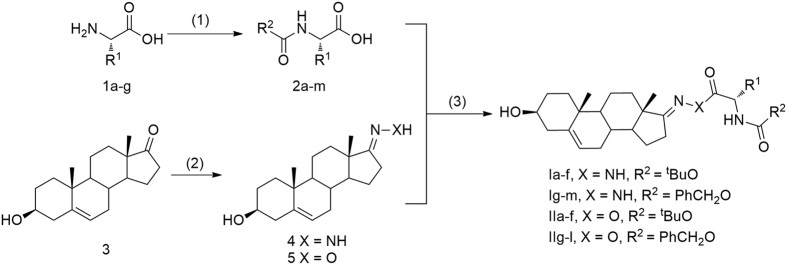
Synthetic route and conditions for target compounds.(1) (Boc)2O or CbzCl, NaOH, 0 oC to rt, yields 65–80%; (2) NH2NH2·H2O, EtOH (X = NH) or NH2OH·HCl, CH3COONa, EtOH (X = O), reflux, yields 80–85%; (3) CDI, Et3N, MeCN, rt, yields 50–80%.